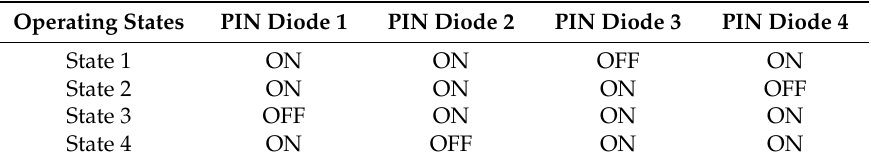
Table 2. The antenna operating states.